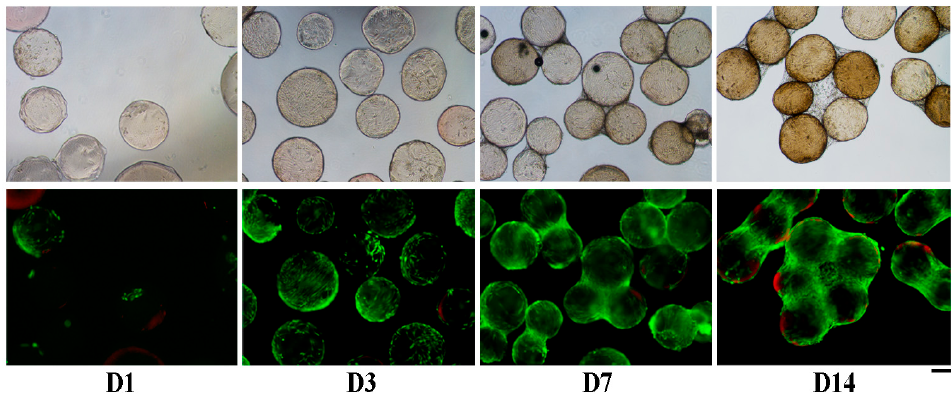
Figure 5. Phase contrast (top) and fluorescence microscopy (bottom) images of Live and Dead stained cells (green: live cells; red: dead cells) with FAMs at 1, 3, 7, and 14 days (D1, D3, D7, D14) from cell seeding. Scale bar = 200 μ m.